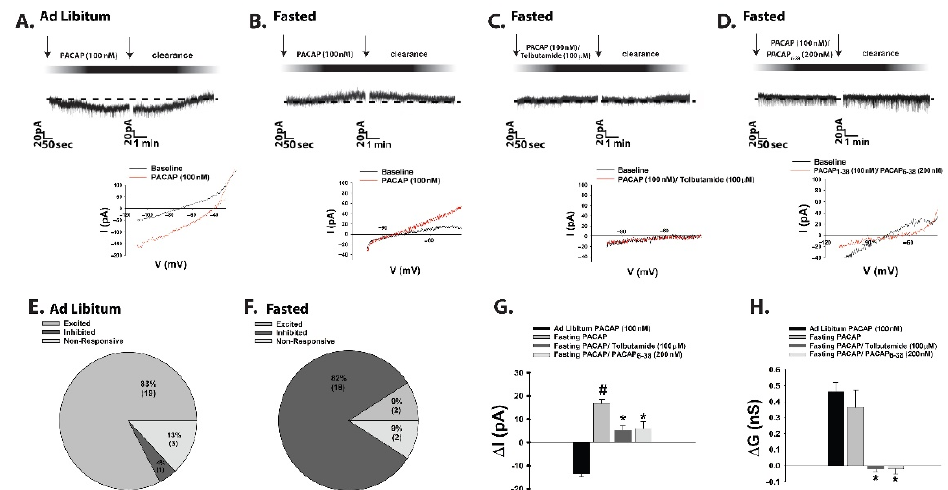
Figure 2. Fasting reverses the polarity of postsynaptic PACAP response in POMC neurons by switching the coupling of PAC1 receptors from TRPC5 to K ATP channels. ( A – D ), Representative current traces from voltage clamp recordings of POMC neurons that depict the response elicited by 100 nM PACAP under ad libitum and fasting conditions, the latter of which is abrogated by blockade of K ATP channels with tolbutamide (100 µ M) and PAC1 receptors with PACAP 6–38 (200 nM). The inset I/V plots illustrate that the fasting-induced change in polarity is due to a switch from a mixed cation conductance to a PAC1 receptor-mediated K + conductance via K ATP channels. ( E , F ), Pie charts that show the proportion of POMC neurons that are excited by, inhibited by, or unresponsive to PACAP under ad libitum (to the left) and fasting (to the right) conditions. ( G , H ) highlight the PACAP-induced changes in membrane current ( ∆ I) and conductance ( ∆ G); alone ( n = 12) and in conjunction with tolbutamide ( n = 12) and PACAP 6–38 ( n = 8). Bars represent means and lines 1 SEM. #, p < 0.05 relative to PACAP under ad libitum conditions. *, p < 0.05 relative to PACAP under fasting conditions, one-way ANOVA/LSD. Figure adapted from [12].